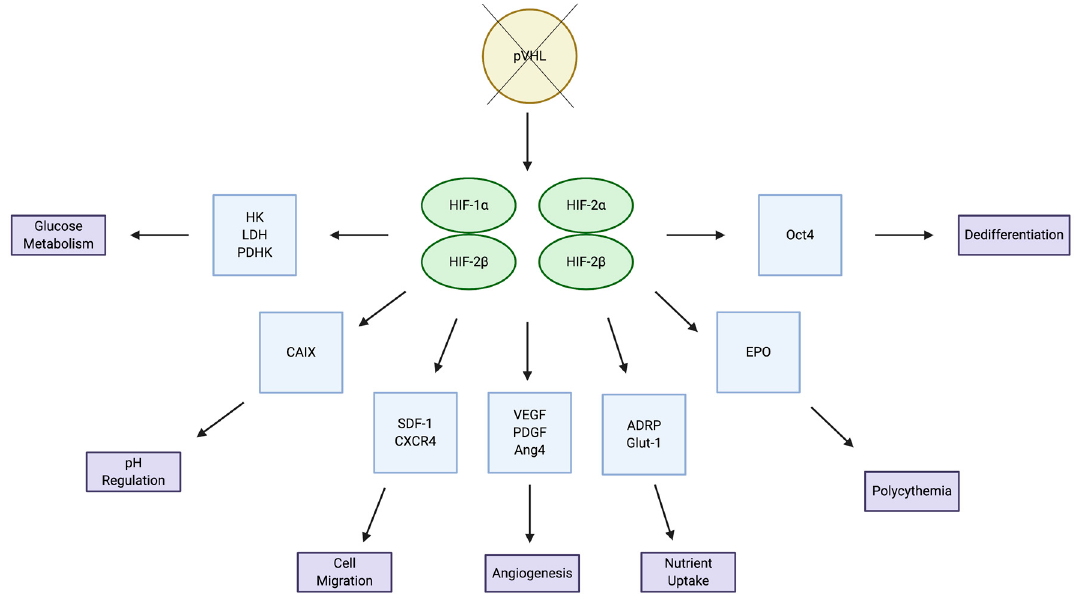
Figure 2. Overlapping and distinct target genes and pathways for HIF-1a and HIF-2a.